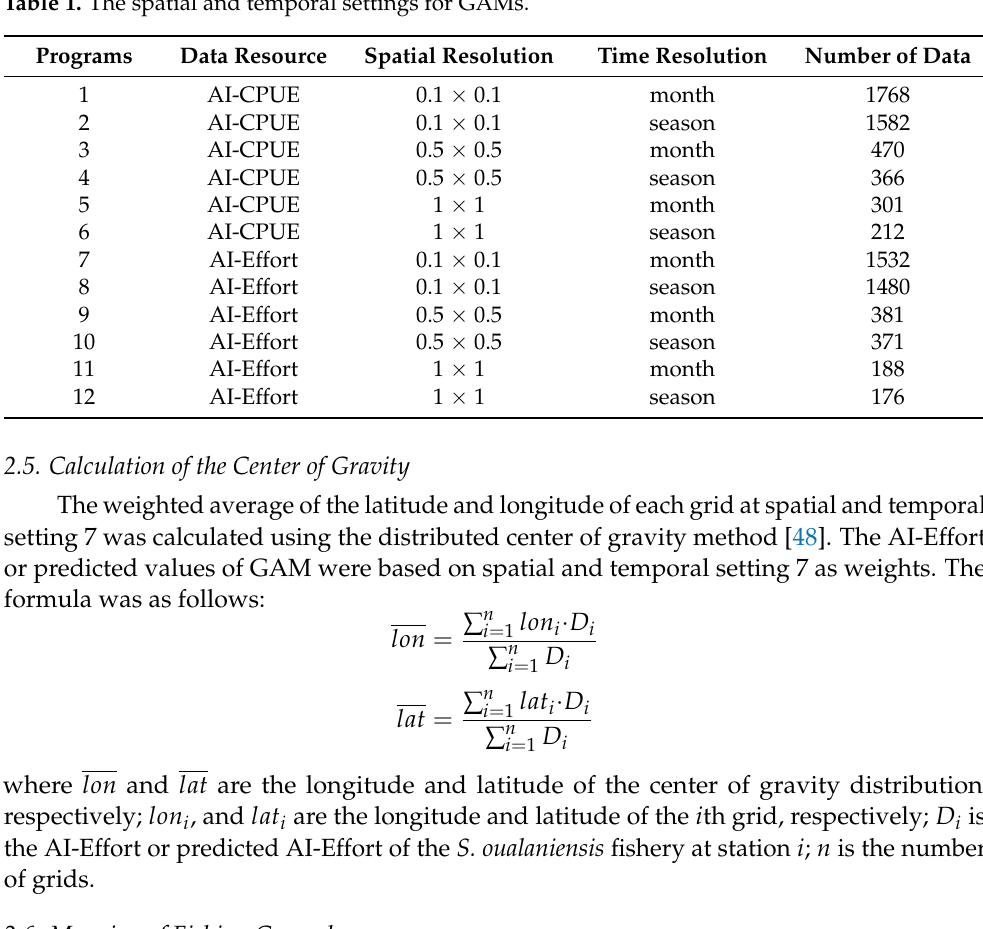
Table 1. The spatial and temporal settings for